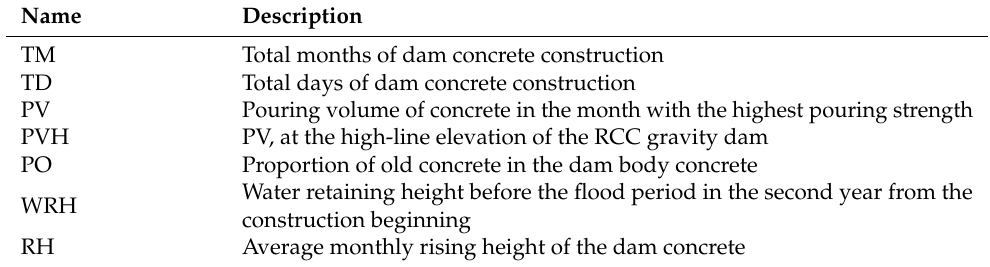
Table 7. Table of progress attributes used for assessing the dam construction